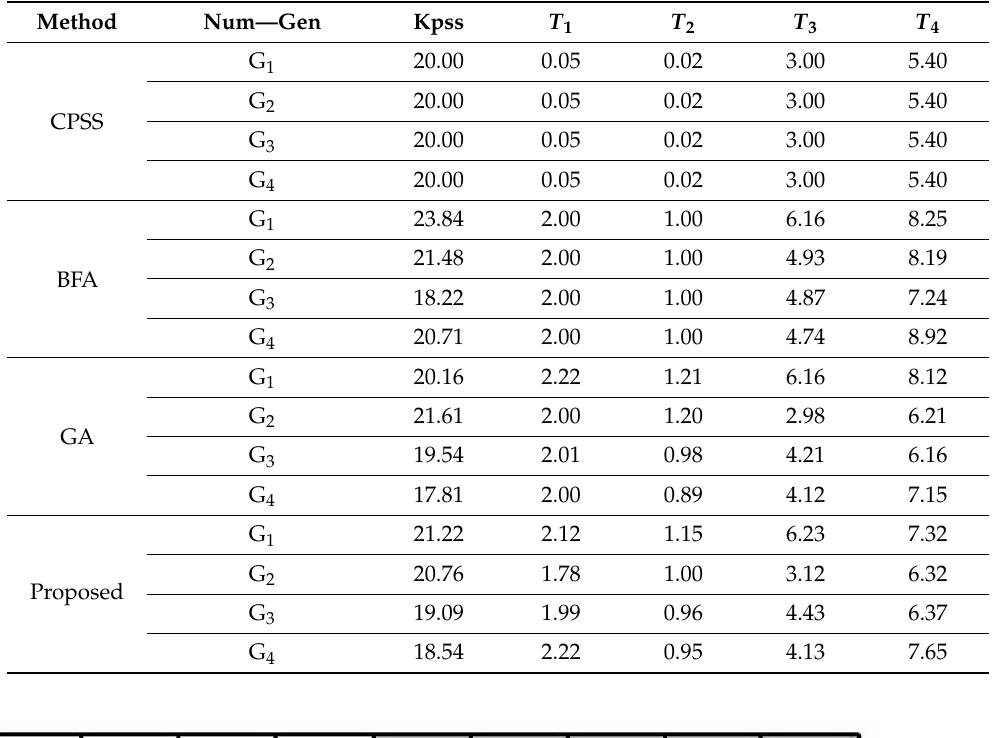
Table 3. The results obtained for the four-machine PSS.